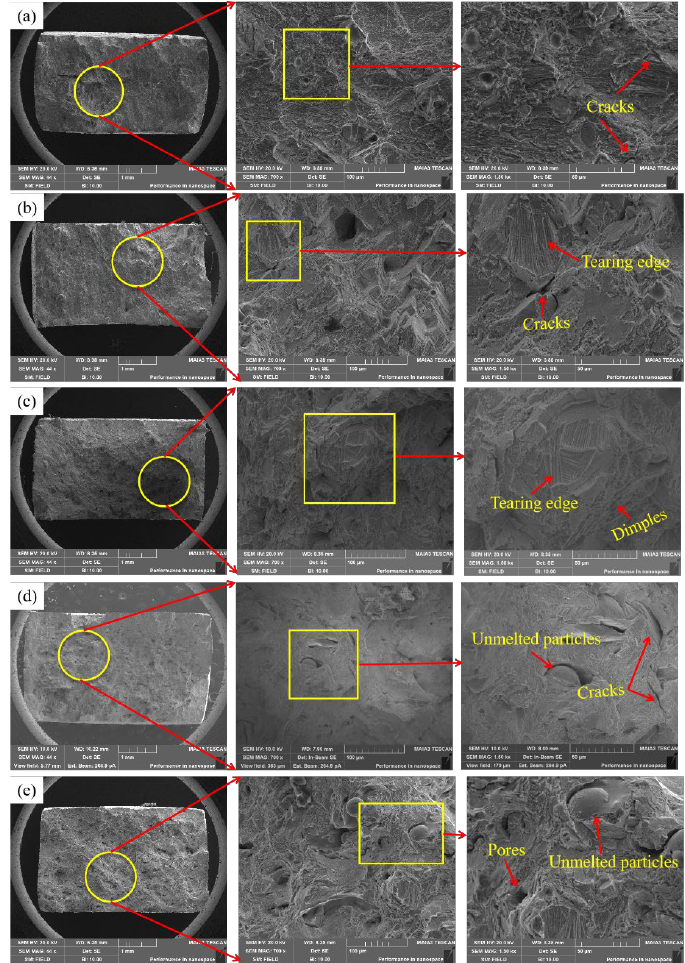
Figure 11. SEM morphology of tensile fractures corresponding to different laser powers (( a ) 800 mm/s; ( b ) 1000 mm/s; ( c ) 1200 mm/s; ( d ) 1400 mm/s; ( e ) 1600 mm/s).